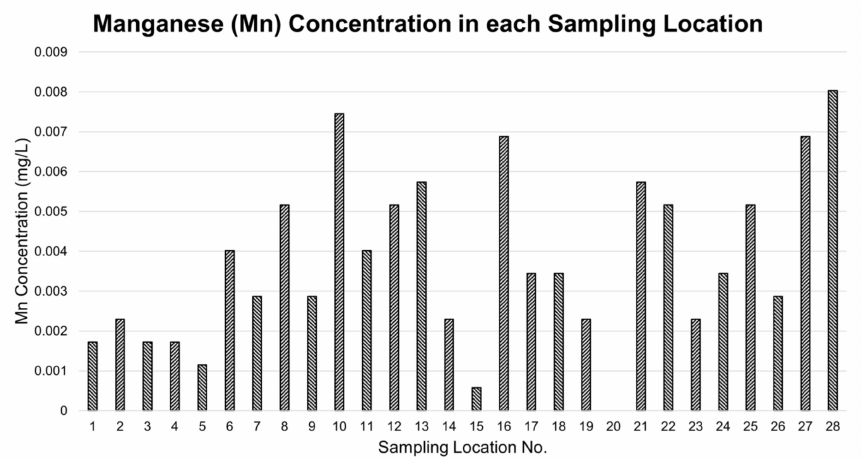
Figure 6. Concentration of Mn in GW